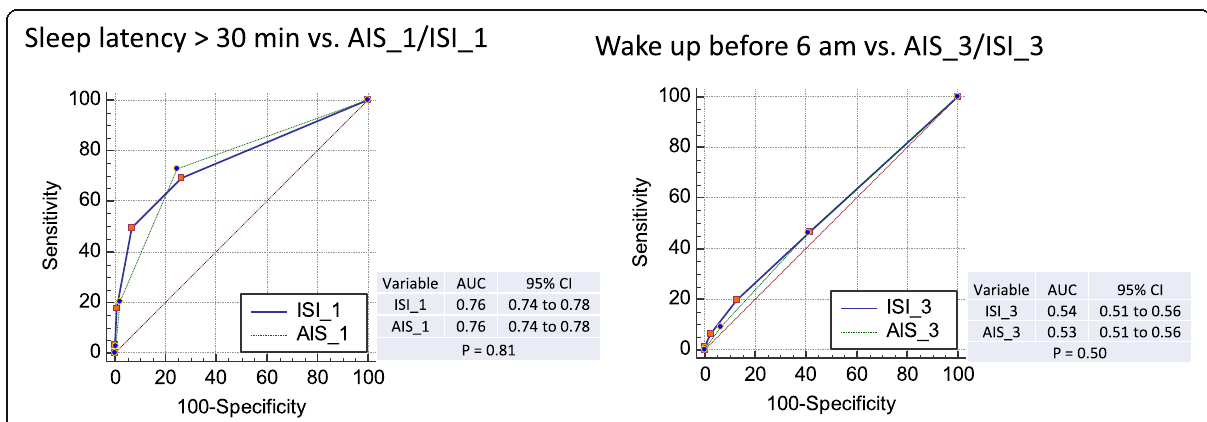
Fig. 3 Receiver operating characteristic (ROC) analysis of the Athens Insomnia Scale (AIS) and Insomnia Severity Index (ISI) scores, long sleep latency, and early waking. ISI_1, first ISI item: sleep-onset; AIS_1, first AIS item: sleep initiation; ISI_3, third ISI item: early morning awakening; AIS_3: third AIS item: early morning awakening. The p values represent the pairwise comparisons of the ROC curves of the ISI and